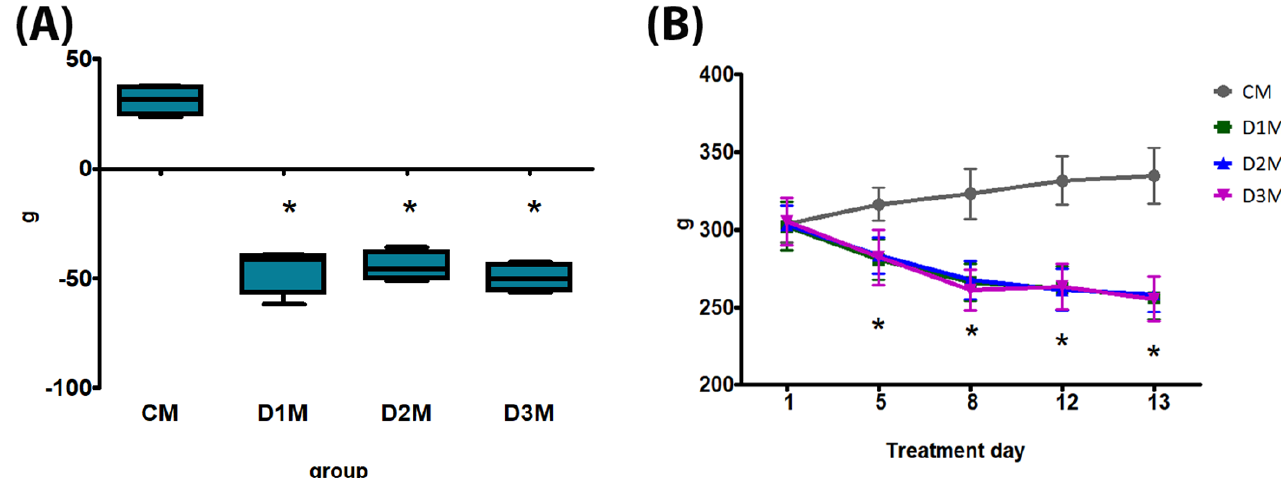
Figure 1. Body weight (bw) of male rats subcutaneously treated with different doses of estradiol valerate plus cyproterone acetate five times a week, for 2 weeks: CM: 0 — sesame oil, D1M 0.09 + 0.33, D2M 0.09 + 0.93 and D3M 0.18 + 0.33 mg. Panel ( A ) bw gain and ( B ) bw at treatment days 5, 8, 12 and 13. Data are presented as mean ± standard deviation. Statistical significance: * p < 0.05 Mann – Whitney test.